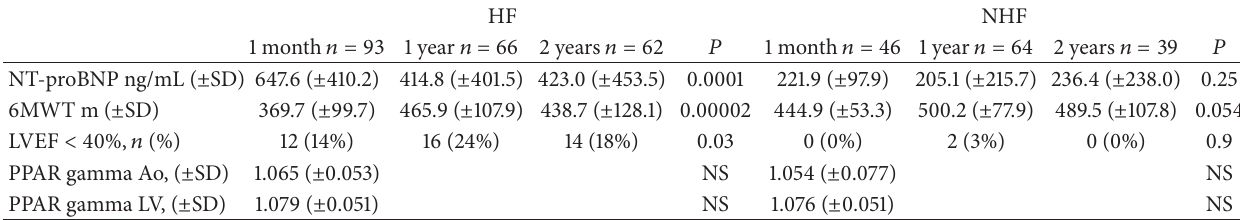
Table 1: Temporal changes of crucial clinical parameters in patients with (HF) and without heart failure